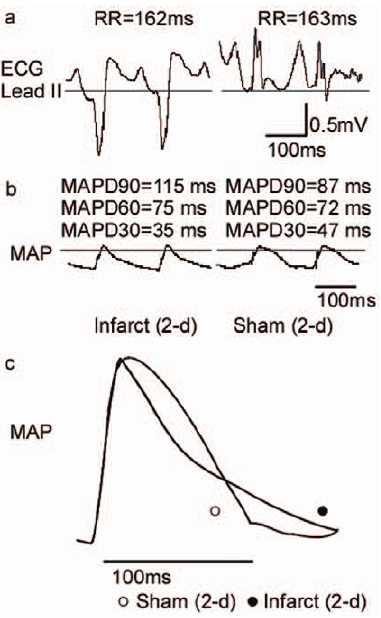
Figure 4. Comparison of waveforms between the Sham (2-d) and Infarct (2-d) groups after bolus injection of epinephrine. The only morphological differences in peri-infarct MAP were identified in the Infarct (2-d) group. ( A ) ECG Lead II waveforms showing that both groups had a comparable degree of heart rate increase. ( B ) MAP recorded at the peri-infarct epicardial zone showing that after the adrenergic challenge, the MAP of the Infarct (2-d) group had a dramatic shortening of MAPD30, whereas the MAPD90 was only minimally changed. ( C ) Direct overlapping of MAP showing that the MAP of the Infarct (2-d) group demonstrates more prominent triangulation.